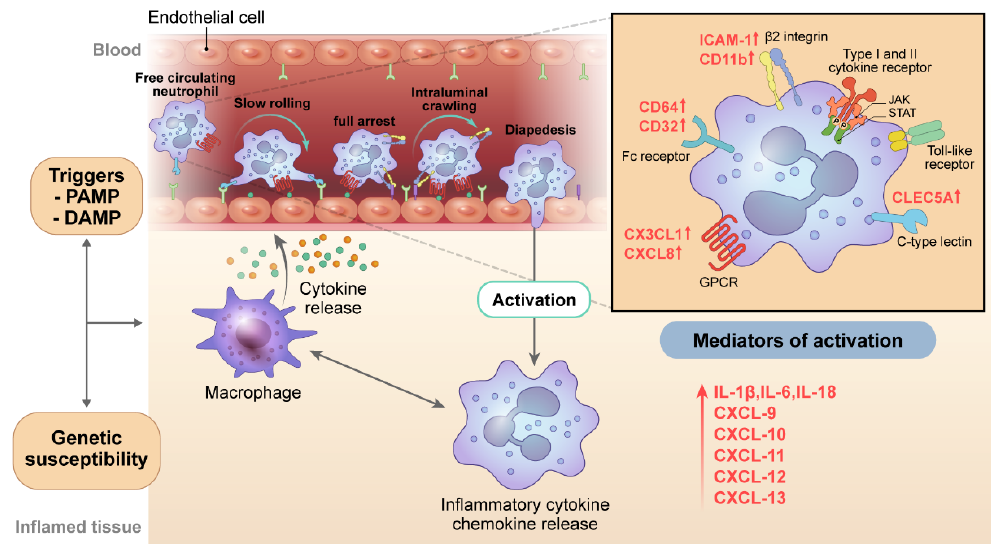
Figure 1. Overview of the role of neutrophils in AOSD and SJIA. Circulating neutrophils are triggered by the release of pathogen-associated molecular pattern molecules (PAMPs) or damage-associated molecular pattern molecules (DAMPs) during inflammation and transmigrate into inflamed tissues. In AOSD and SJIA, a variety of specific receptors on neutrophils, including pattern-recognition receptors and Fc receptors interacting with PAMPs and DAMPs increase, further promoting neutrophil recruitment and activation. Activated neutrophils release more cytokines/chemokines and communicate with macrophages in the innate immune system. Neutrophil activation and mediator release form a positive-feedback loop that enhances neutrophil recruitment and amplifies inflammatory responses, acting as an axis of pathogenesis in AOSD and